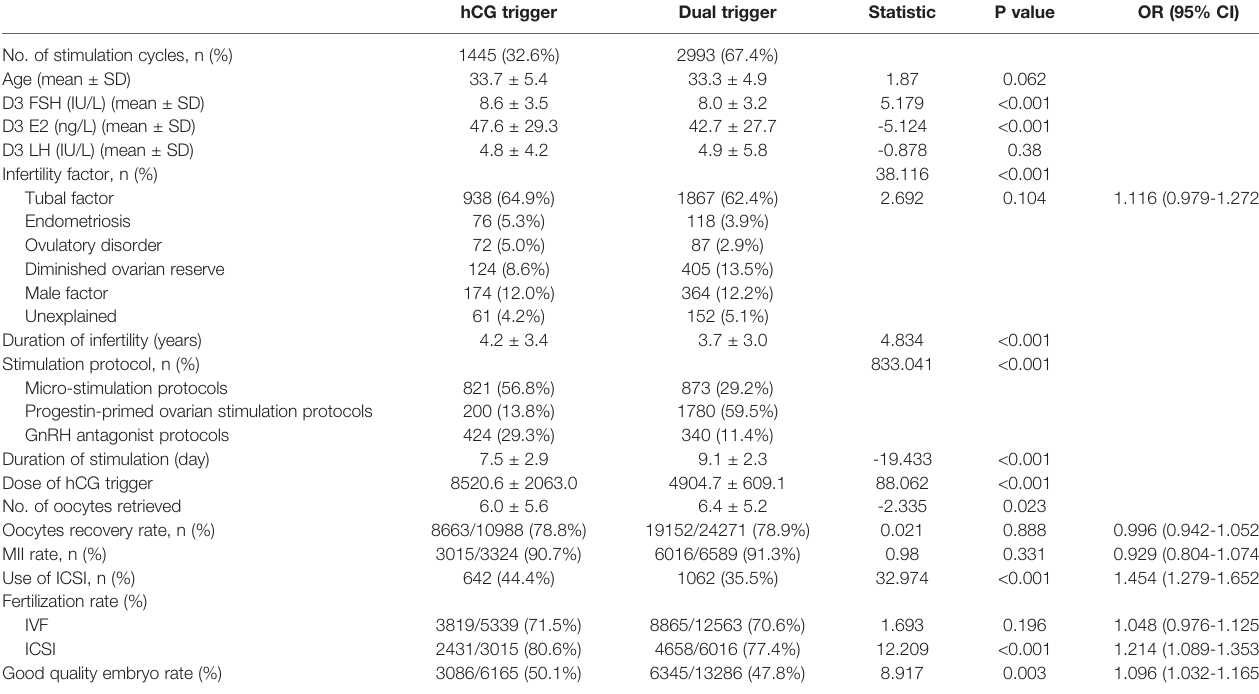
TABLE 1 | Basal characteristics and fresh IVF/ICSI